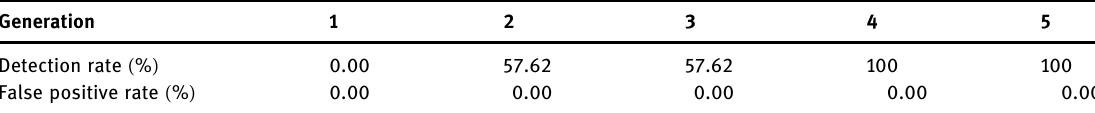
Table 3: Detection result for an example of an equivalence subclass Generation